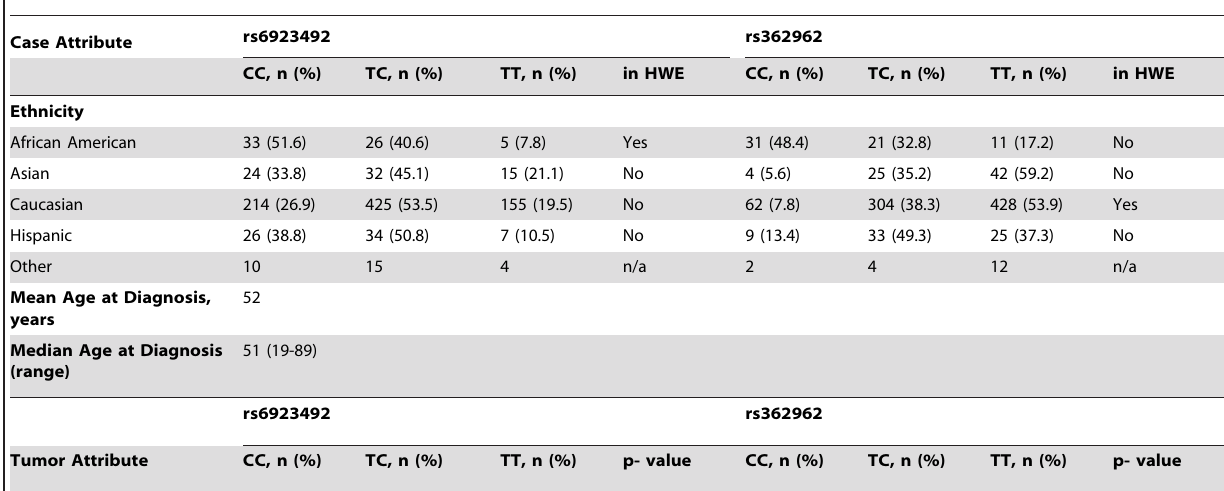
Table 1. Demographics for study participants by GRM1